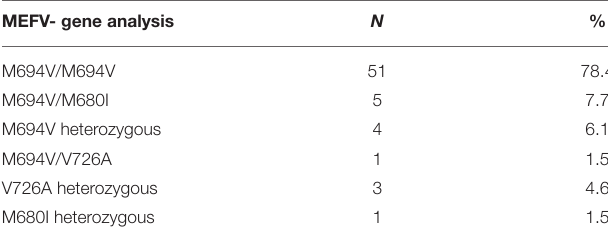
TABLE 2 | MEFV- gene analysis in patients receiving